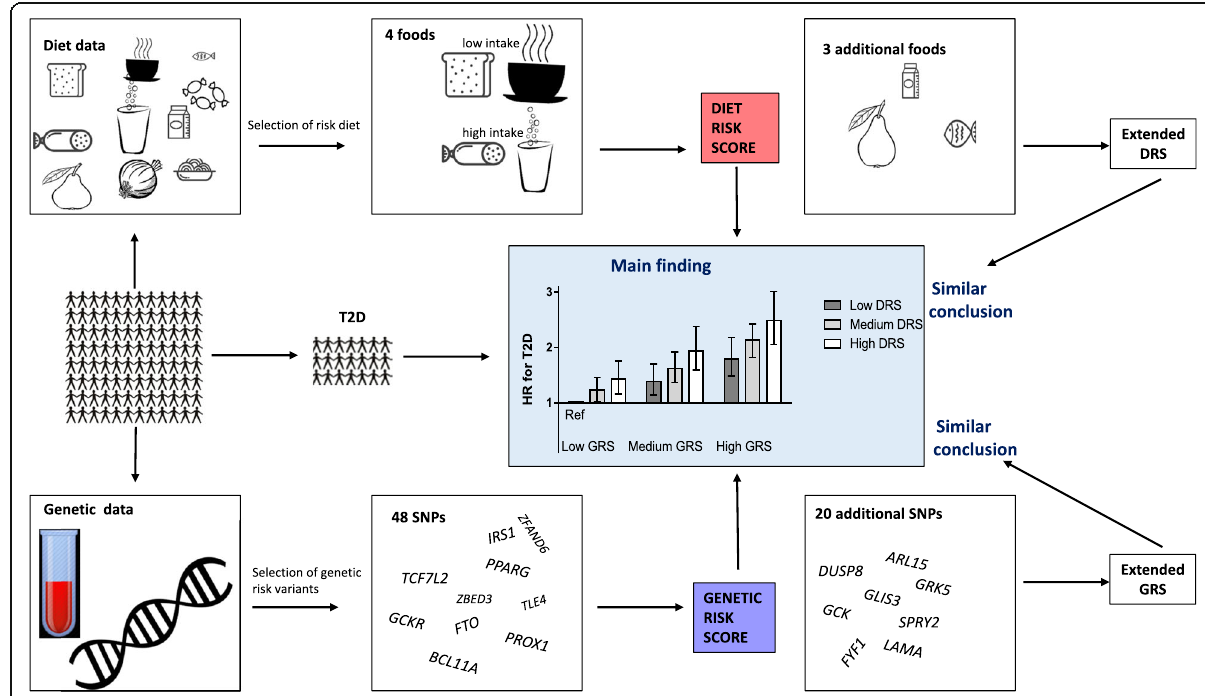
Figure 2 The positive association of similar magnitude independent of genetic predisposition to T2D, assessed using a GRS composed of 48 SNPs identified in GWAS for T2D